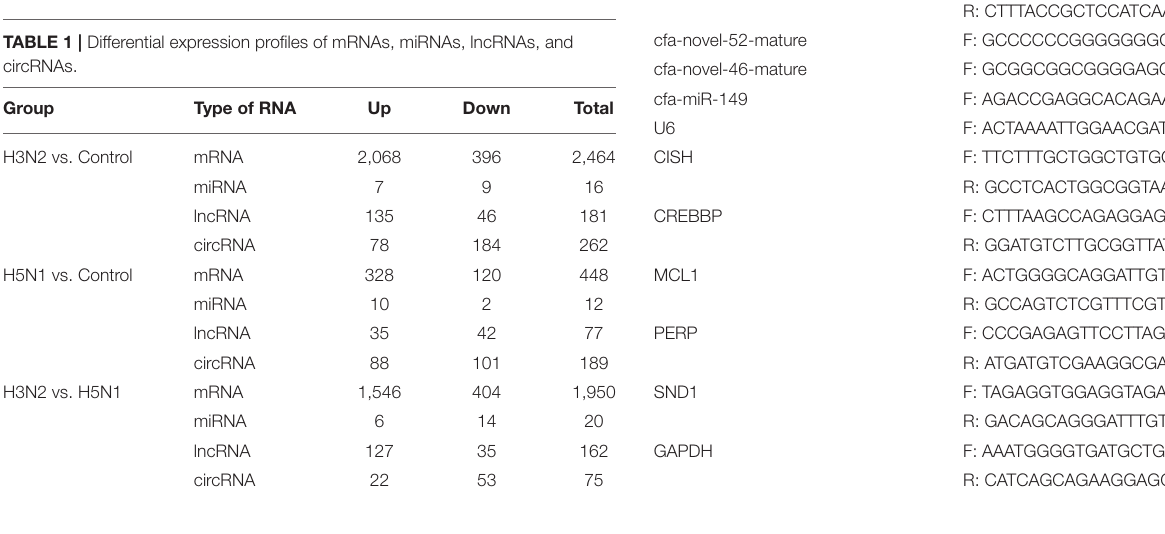
Frontiers in Cellular and Infection Microbiology |